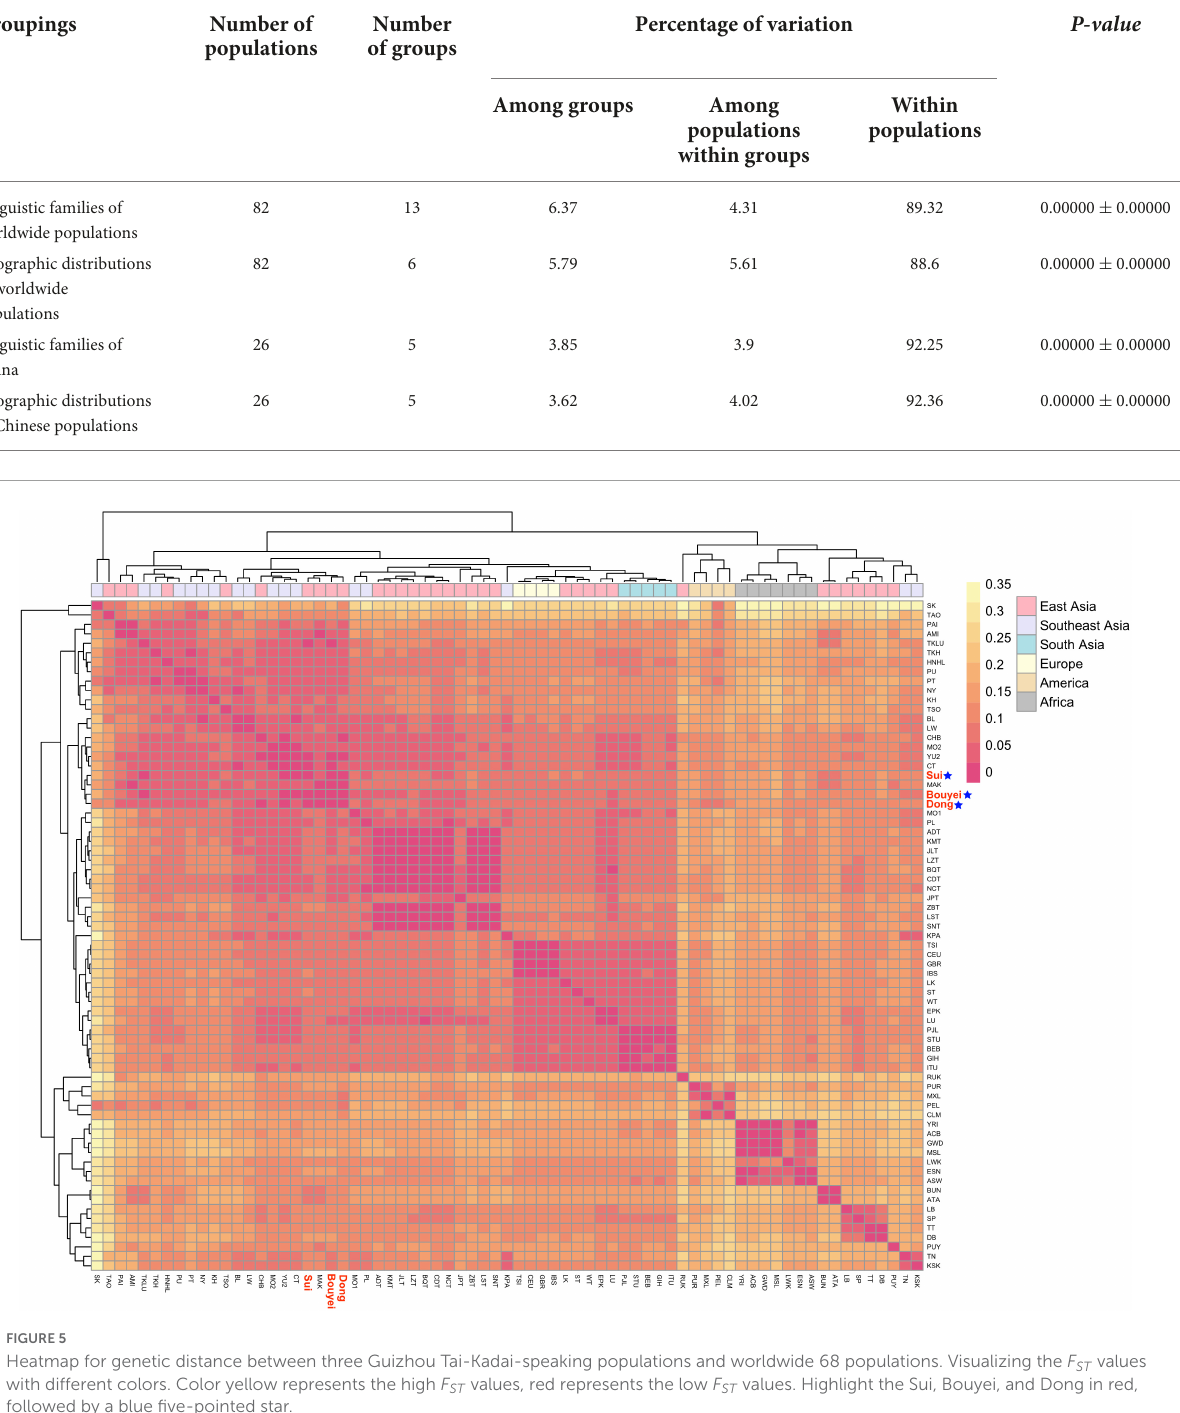
TABLE 3 Analysis of molecular variance (AMOVA) results based on different groups for worldwide populations.